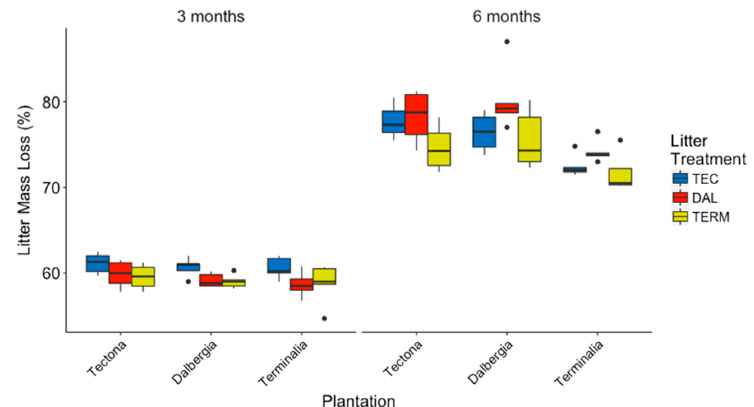
Figure 4. Litter mass loss after three months (April 2017) and six months (July 2017) in a litter decomposition experiment in monoculture plantations of Tectona grandis, Dalbergia retusa and Terminalia amazonia in Panama, Central America. Mass loss was measured for each litter type in all plantations, where TEC is Tectona grandis , DAL is Dalbergia retusa and TERM is Terminalia amazonia litter ( n = 5).